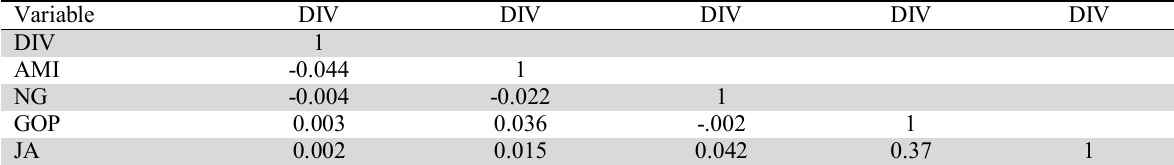
Correlation coefficient of independent variables Variable